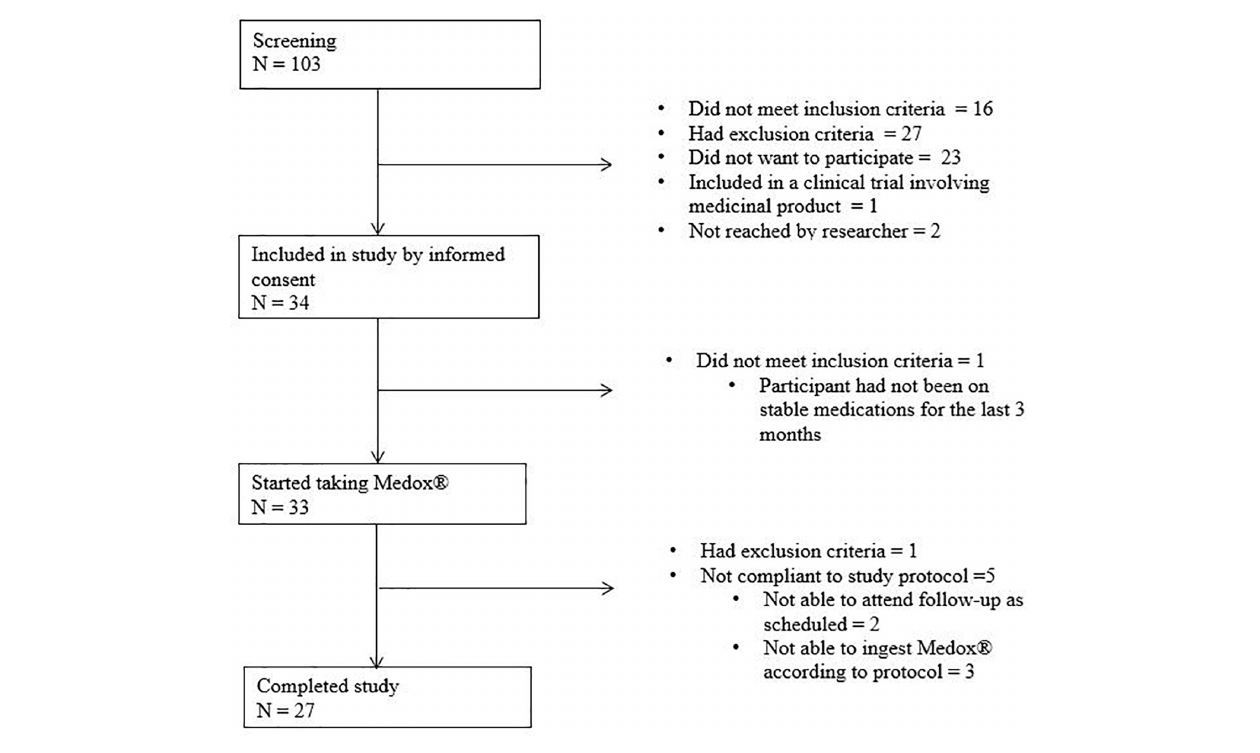
FIGURE 1 | Enrolment of participants. N, number.